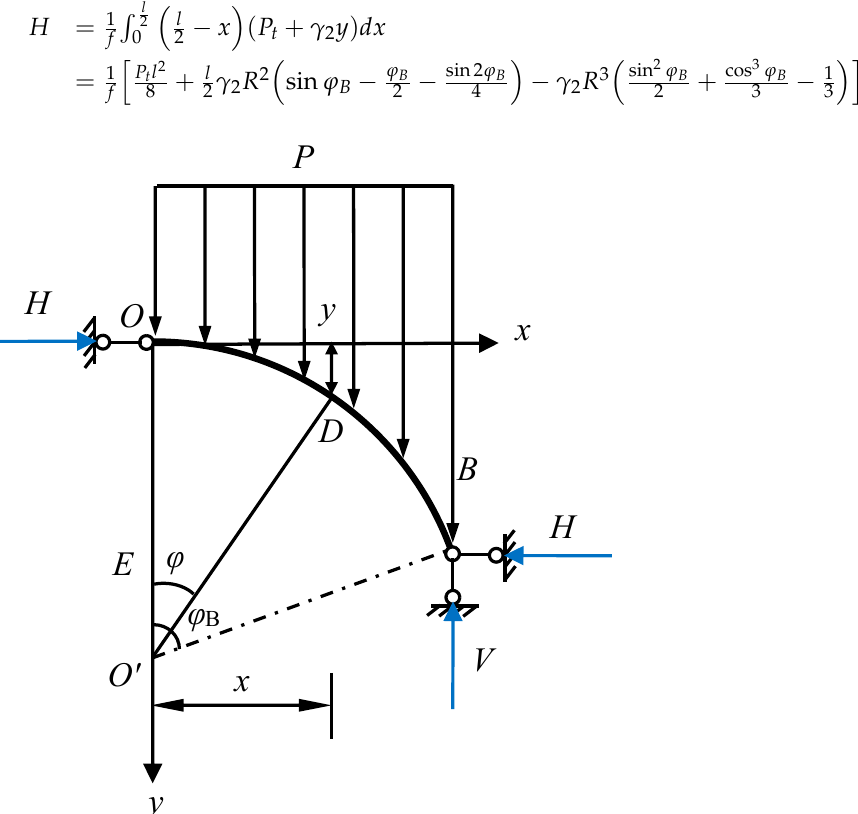
Figure 8. Half-side structure of the three-hinged arch.